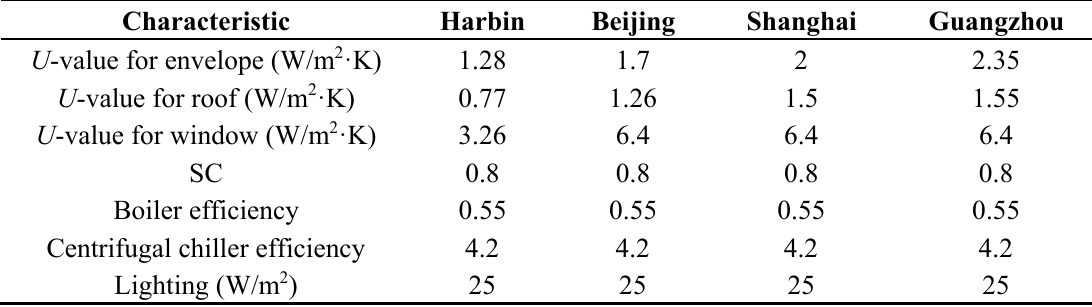
Table A2. Characteristics of the reference model per climate zone.